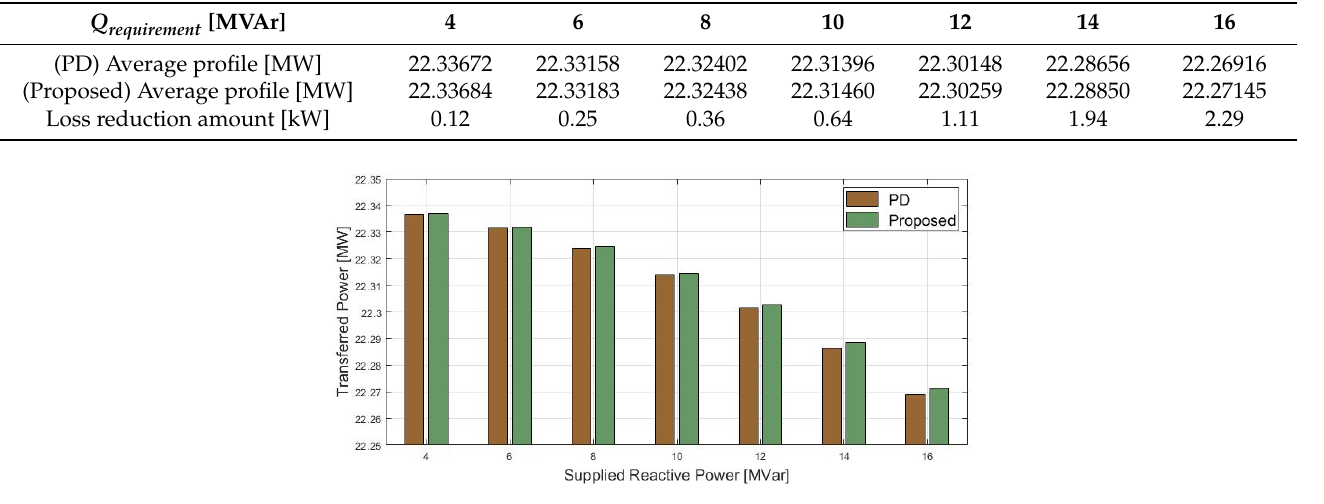
𝑄𝑄 𝑝𝑝𝑝𝑝𝑝𝑝 = 4 𝑀𝑀𝑉𝑉𝑀𝑀𝑟𝑟